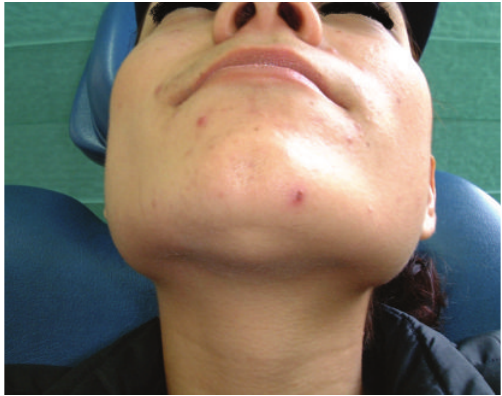
Figure 1: The semihard, painless, slowly evolving augmentation in the submental area.